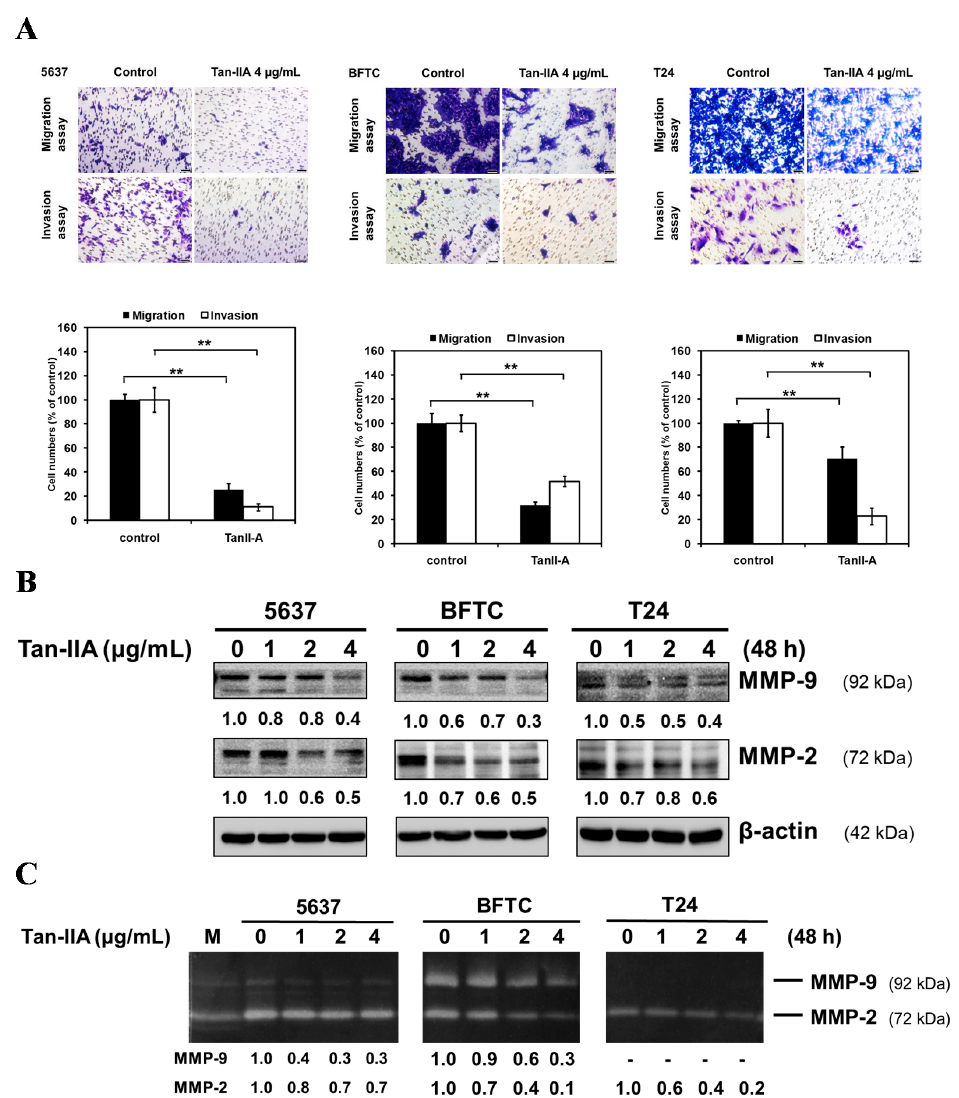
Figure 1. Tan-IIA inhibited migratory and invasive ability in human BCa cells. ( A ) Human BCa cells were treated with 0.2% DMSO as a vehicle control or 4 μ g/mL Tan-IIA for 24 h and then seeded onto the transwell hanging insert for migration (24 h) and invasion (48 h) assays. Images were captured using an inverted microscope with 200× magnification; Scale bar: 50 μ m. The migration and invasion of BCa cells were quantified by counting the stained cells that migrated into the underside of the hanging insert membrane; ( B ) human BCa cells were treated with different concentrations of Tan-IIA (1, 2 and 4 μ g/mL) for 48 h. The protein of total cell lysates were then used to detect MMP-9/-2 protein expression using western blot, and the ( C ) supernatant was used to detect the enzymatic activity using zymography analysis. M: marker. Data are presented as means ± S.D. from three different experiments. ** p < 0.01 versus vehicle.